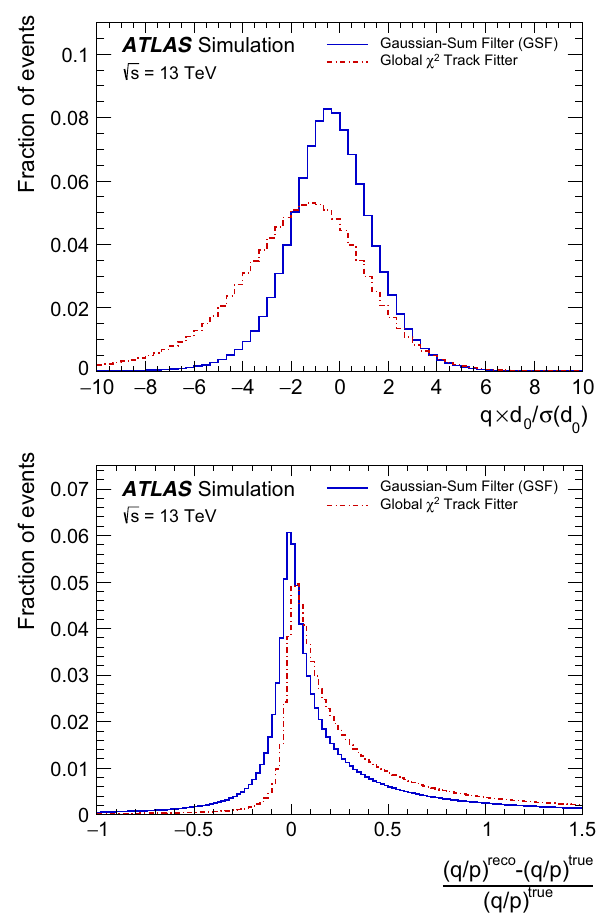
Fig. 3 Distributions of the reconstructed electric charge of the can- didate electron multiplied by the transverse impact parameter signifi- cance, q × d 0 /σ( d 0 ) (top) and the relative difference between the recon- structed value of the candidate-electron charge divided by its momen- tum, q / p , and the true generator value (bottom). The distributions are shownfortracksfittedwiththeGlobal χ 2 TrackFitter(dashedredlines) and for tracks fitted with the GSF (solid blue line). The distributions were obtained from a simulated single-electron sample